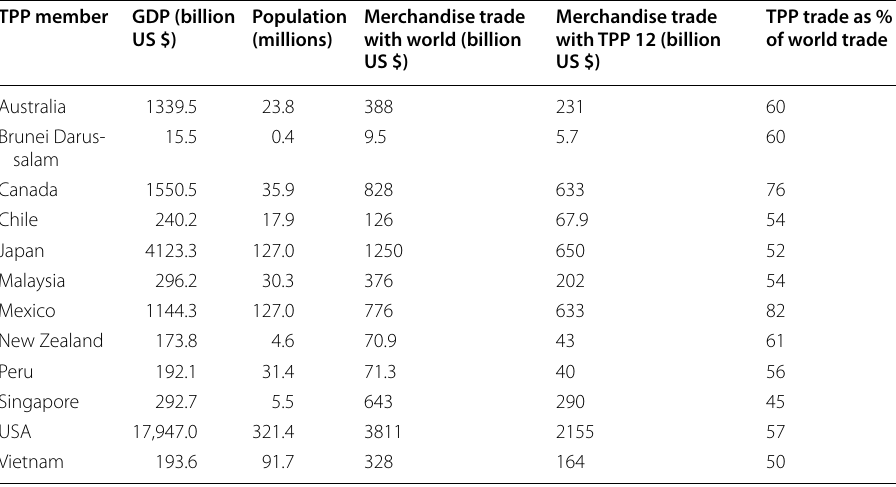
Table 1 Economic profile of TPP 12, 2015. Source : World Bank; UN COMTRADE